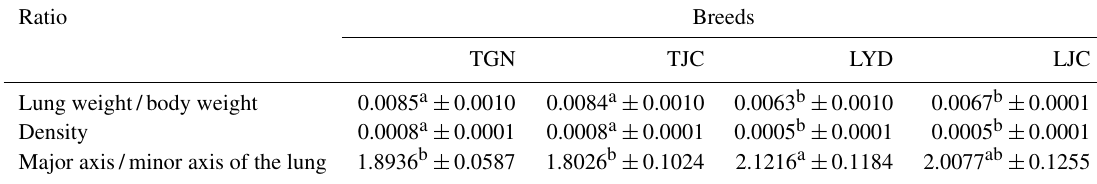
Table 1. Pulmonary morphological indicators.